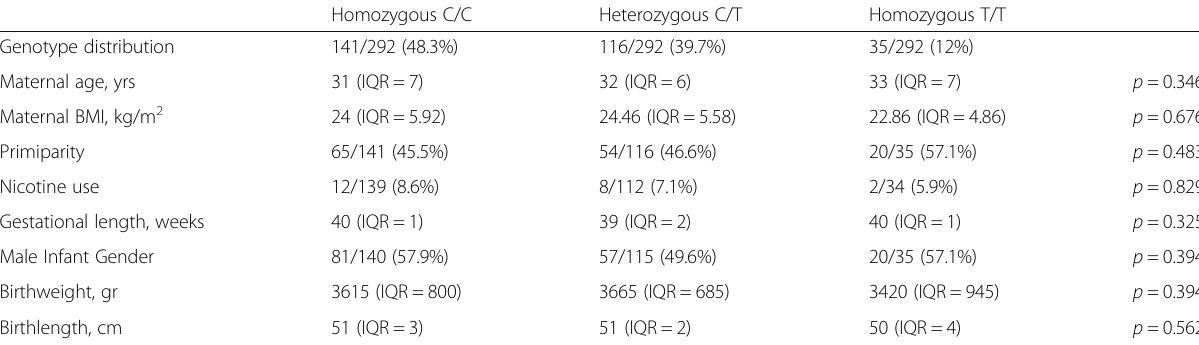
Table 2 Distribution of epidemiological data among different genotypes for HRG C633T polymorphism in the entire